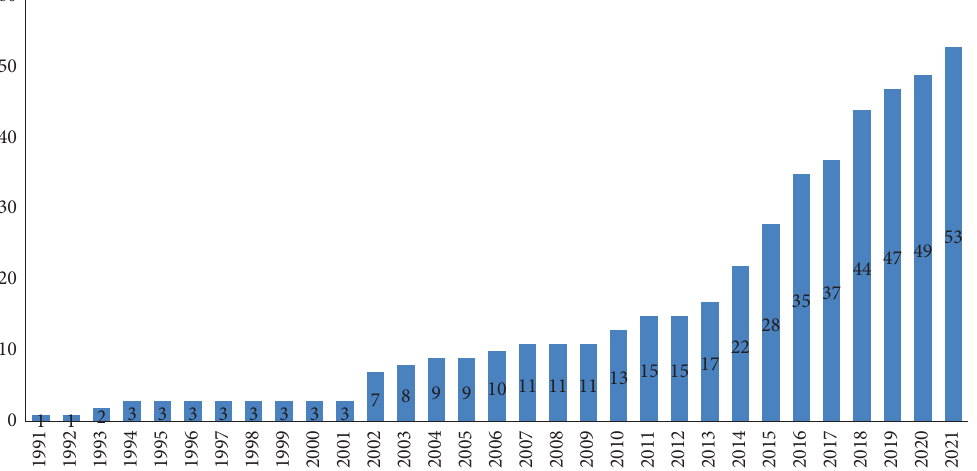
Figure 3: Number of units of nuclear power in operation in China (1991–2021).